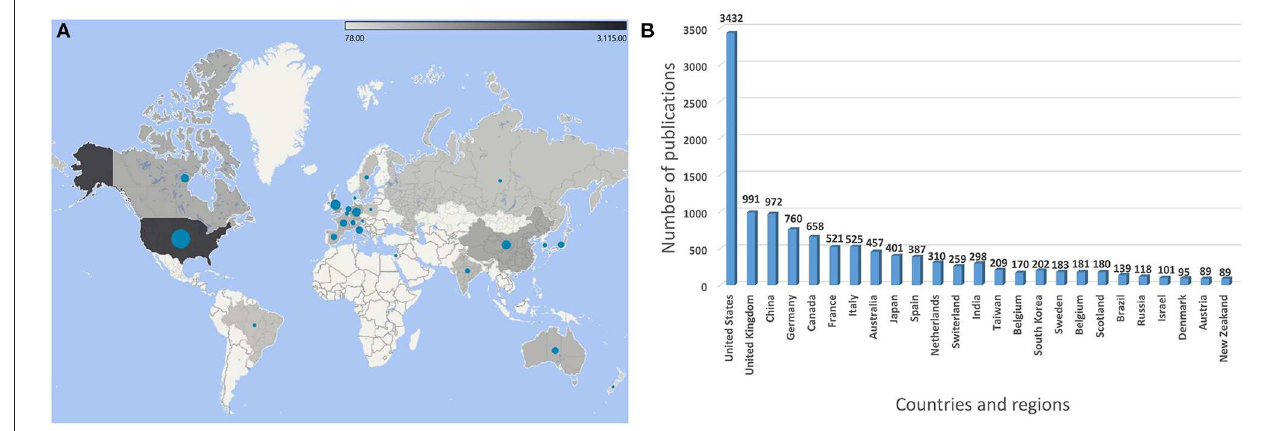
FIGURE 2 | (A) A map and (B) a histogram of publications on fall detection by countries and regions from 1945 to